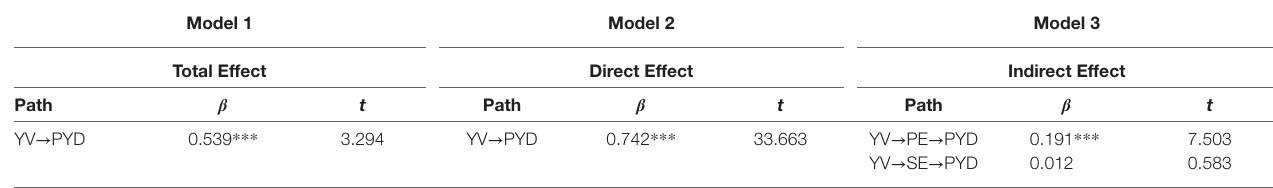
TABLE 3 | Mediation effects of program engagement and safety on relationship between youth voice and positive youth